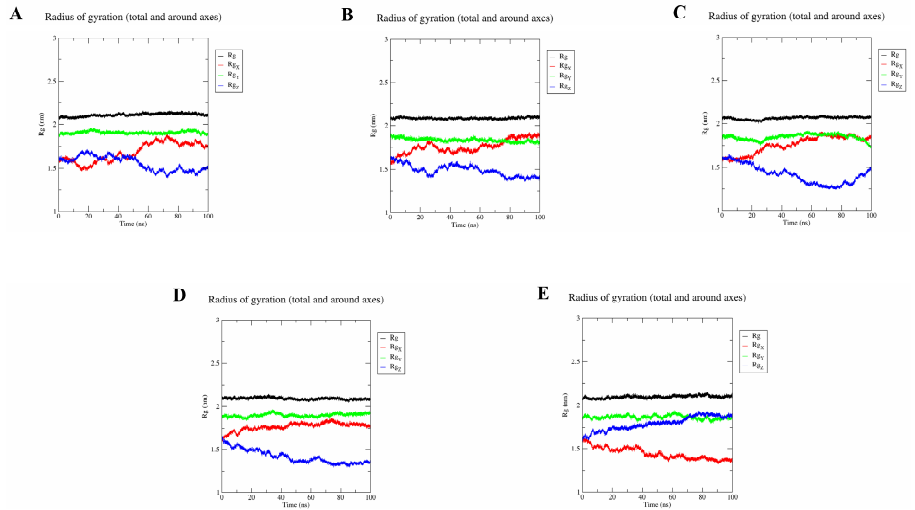
Figure 11. Radius of gyration (Rg) plot of resveratrol ( A ); bisphenol A ( B ); 17 β -estradiol ( C ); G-1 ( D ); G-15 ( E ).